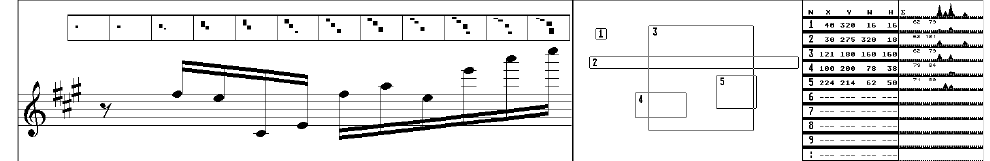
Fig.13: Schematical frames 1-12 of Fischinger’s Study No.6: Estudio Siete